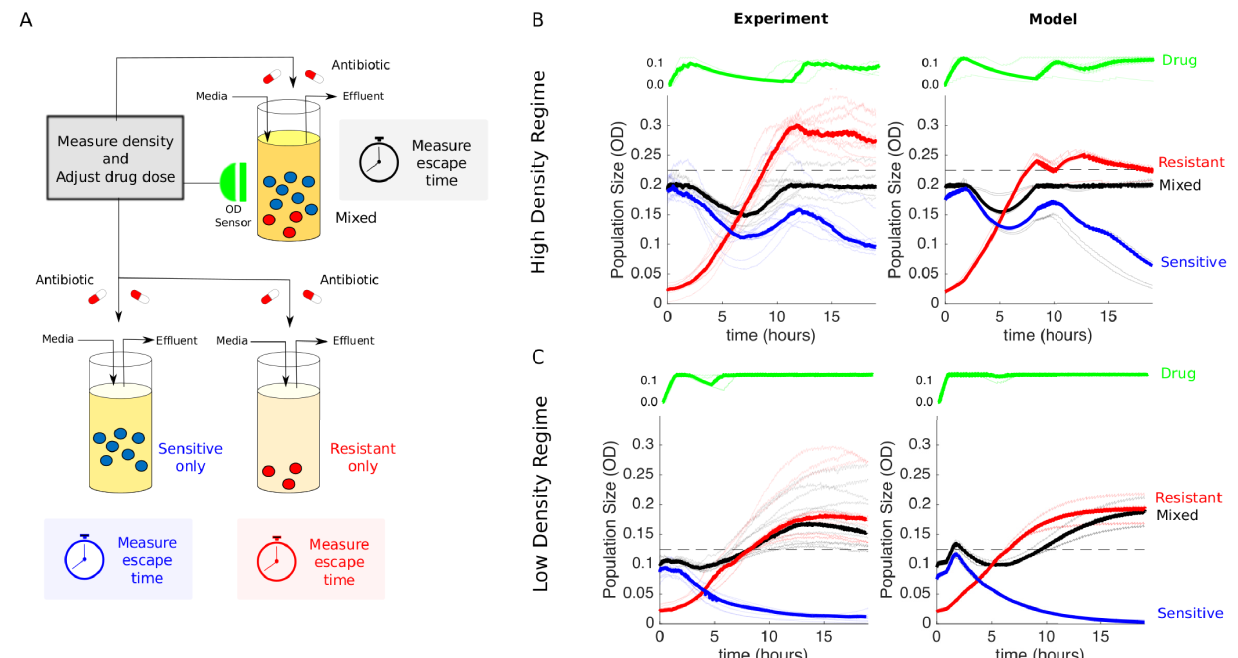
Fig 3. Experimental design and dynamics for comparison to measure effect of “competition maximization”. (A) Schematic of experiment. Three different populations (sensitive-only, resistant-only, and mixed) were exposed to identical antibiotic treatments in separate bioreactors. The medium in each bioreactor was also refreshed at a constant rate of F N = 0.067 mL/min. The drug treatment was determined in real time by measuring the density (OD) of the mixed population and adjusting drug influx to maintain a constant density ( P max ) while minimizing drug used (Methods). Although the dynamics of the mixed population fully determine the temporal profile of the drug dosing, all three populations then receive identical treatments. In the high-density experiment, mixed populations started at an OD of P max = 0.2, with a 90–10 ratio of sensitive to resistant cells. The initial OD of resistant cells is therefore 0.02. Resistant-only populations started from an initial density of 0.02 and contained no sensitive cells, whereas sensitive-only populations started from an initial density of 0.18 and contained no resistant cells. In the low-density experiment, mixed populations started at an OD of P max = 0.1, and the initial OD of resistant cells was unchanged (OD = 0.02). Therefore, the starting conditions of the high- and low-density experiments differ only in the number of sensitive cells. (B and C) Experiments (left) and model (right) in high-density ( P max = 0.2 [B]) and low-density ( P max = 0.1 [C]) regimes. Red curves are resistant only, blue are sensitive only, and black are the mixed populations. Lightly shaded curves correspond to individual experiments, and dark curves show the median across experiments. Horizontal dashed lines show the treatment failure threshold P = 0.025, in which max the 0.025 term allows for small experimental fluctuations without triggering a threshold crossing event. Data are deposited in the Dryad repository: https://doi.org/10.5061/dryad.s4mw6m943 [62]. OD, optical density; P , acceptable max